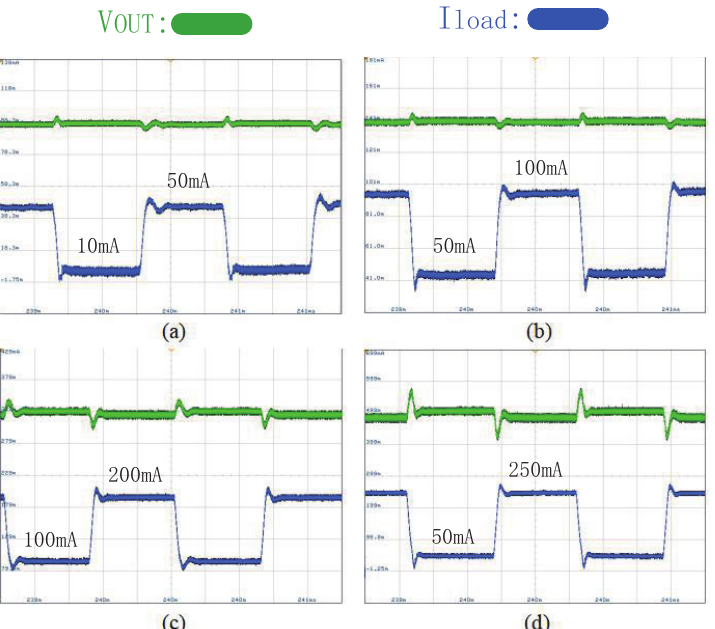
Figure 14. The test results of the load conversion response. ( a ) The load is switched from 10 mA to 50 mA. ( b ) The load is switched from 50 mA to 100 mA. ( c ) The load is switched from 100 mA to 200 mA. ( d ) The load is switched from 50 mA to 250